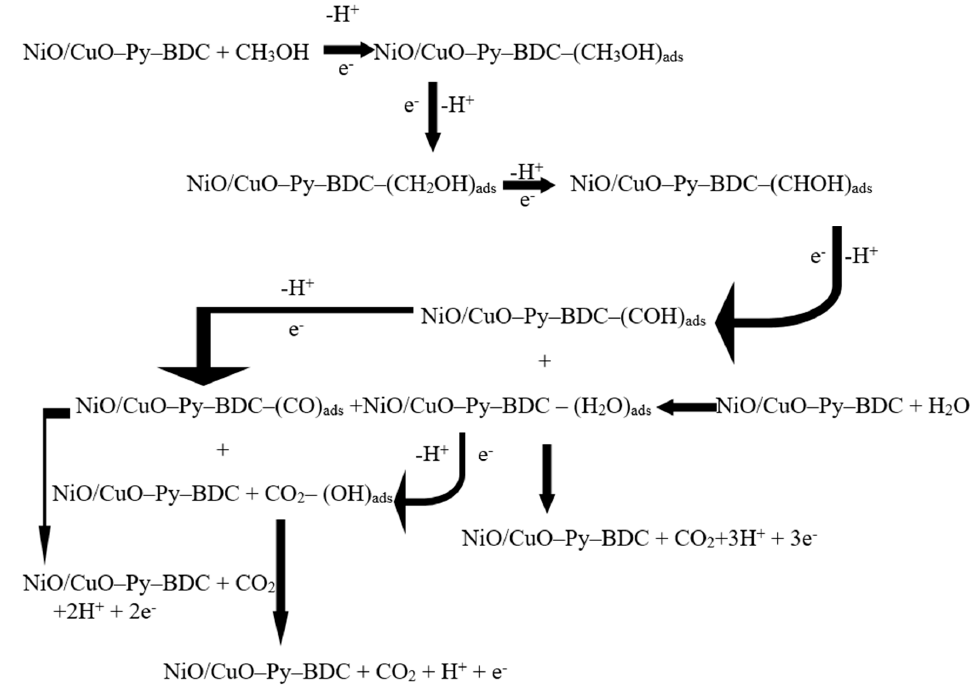
Figure 10. Overall mechanism of methanol oxidation over the surface of catalyst.